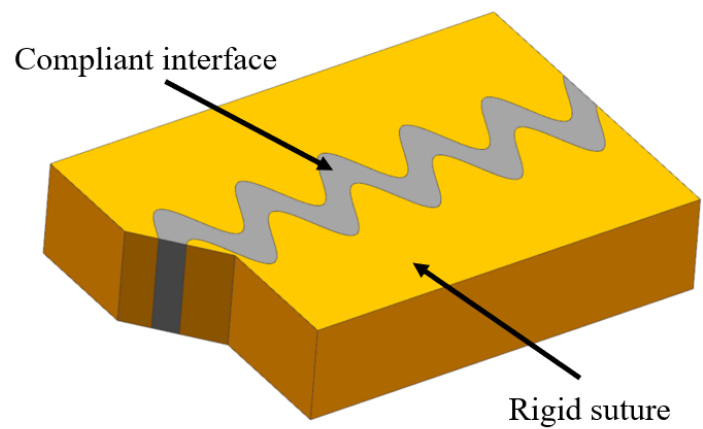
Figure 9. Schematic diagram of the sutured model.